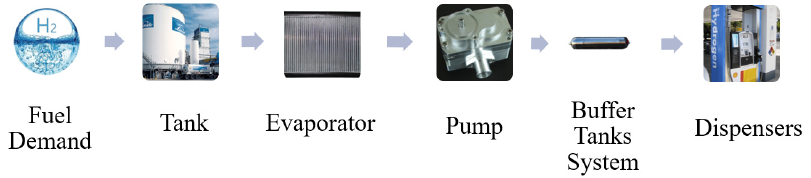
Figure 4. Main parts of HRS system.